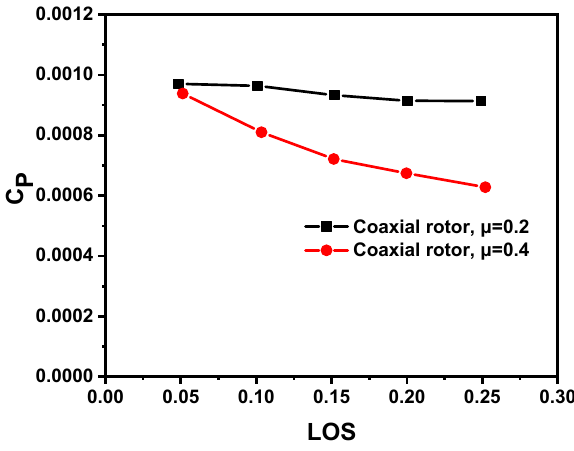
Figure 16. Lateral cyclic pitch of upper and lower rotors (B 1up and B 1lo ) as a function of the lift offset (LOS).